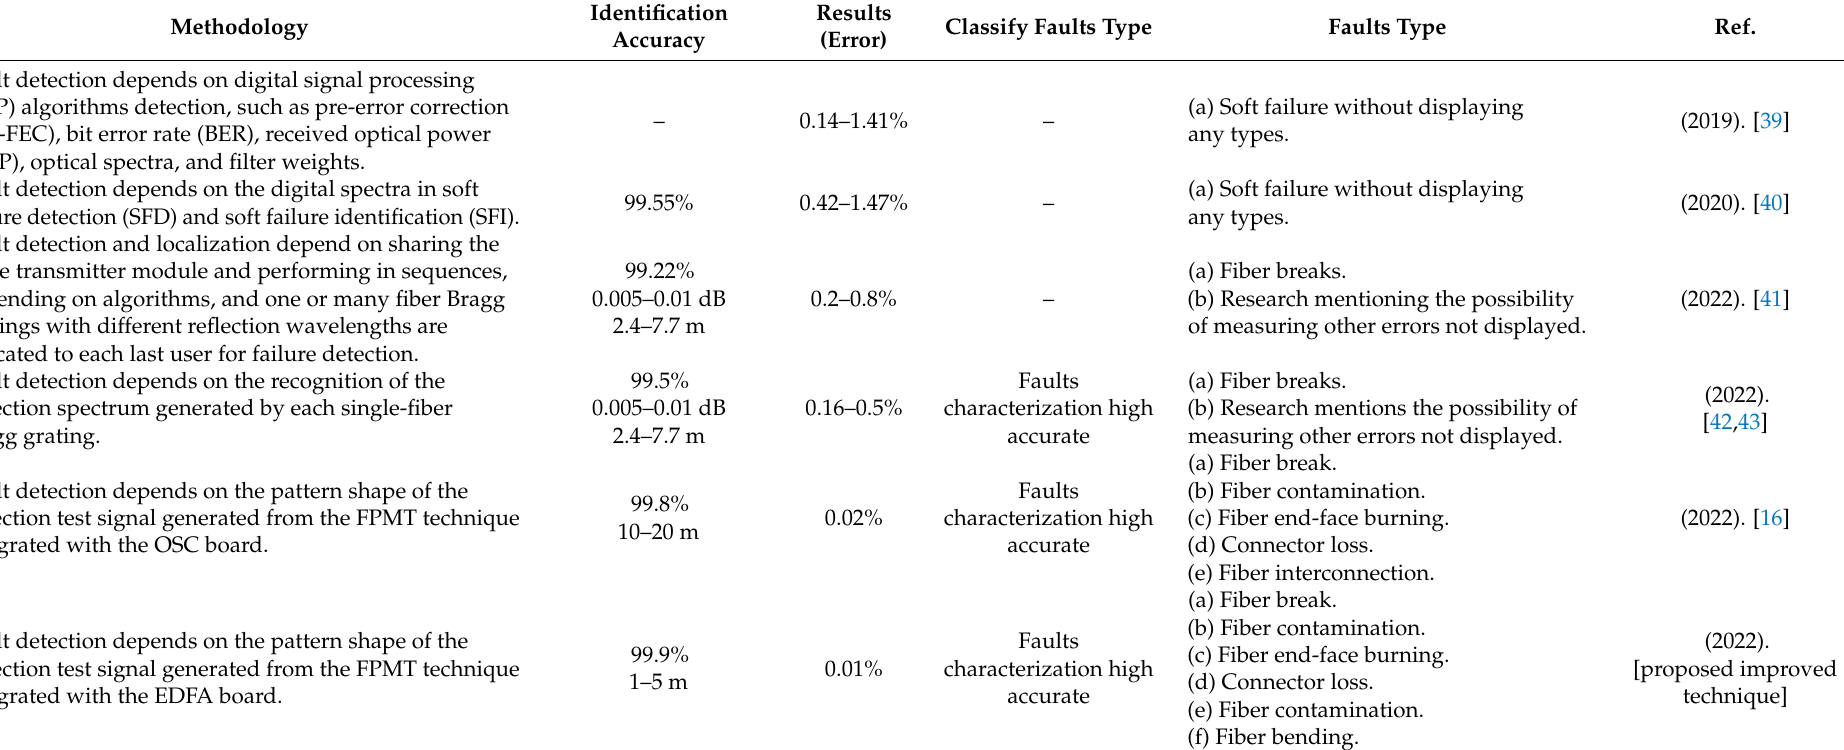
Table 12. Comparison between Improved FPMT technique and the other online